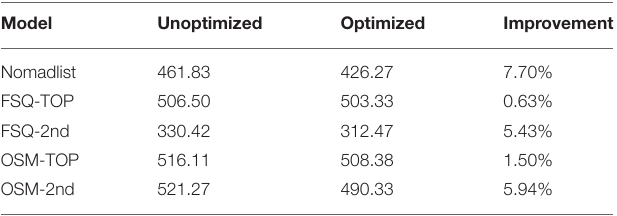
TABLE 5 | Optimization toward the Expert Opinion using Spearman’s Footrule top- k